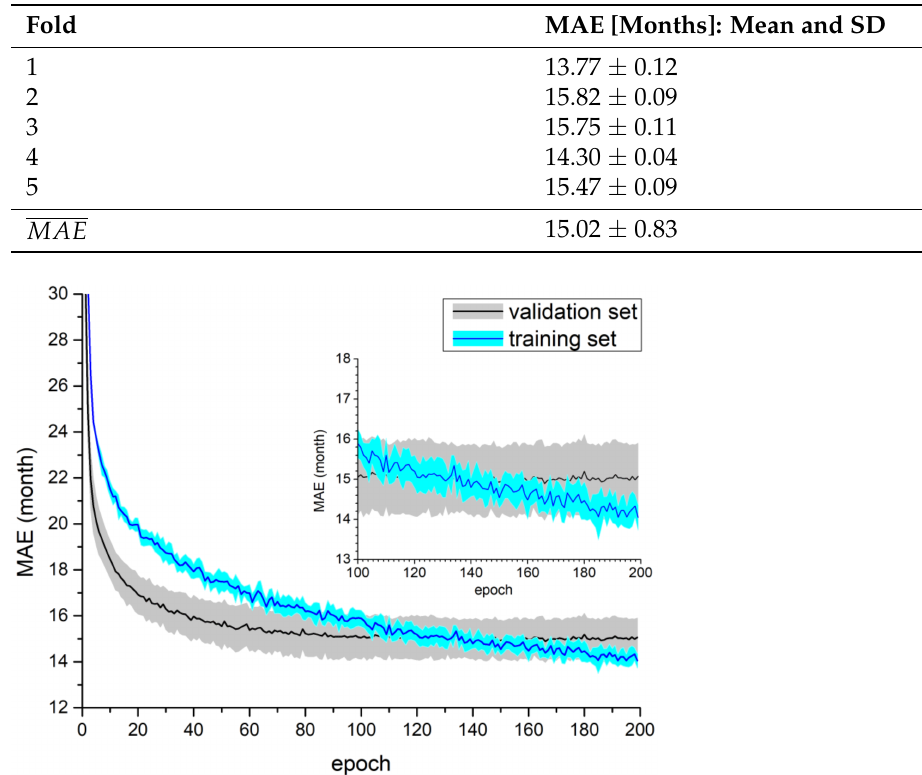
Table 3. Average values and standard deviations of MAE obtained in Experiment II—MobileNetV2 DW model, augDXA dataset. The mean MAE and standard deviation in the last row were calculated from all folds.